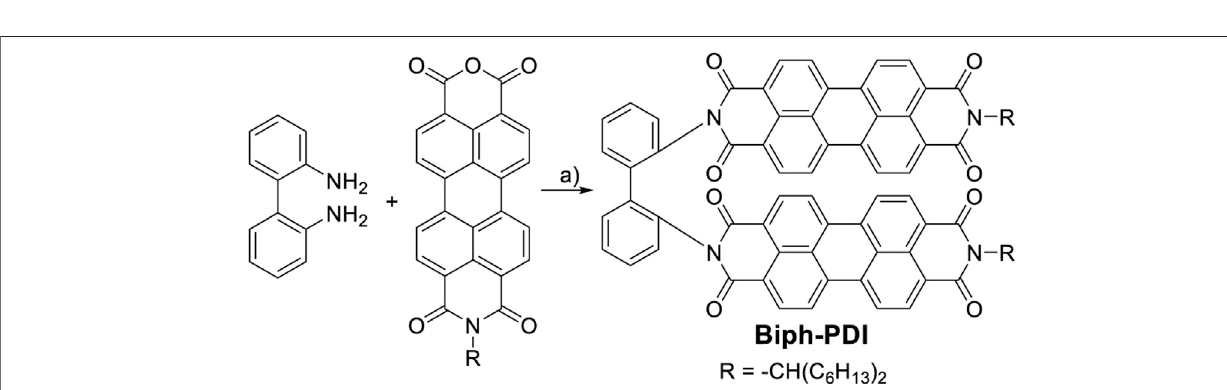
SCHEME1| SyntheticroutetoBiph-PDI.Reagentsandcondition:A)2,2 ′ -biphenlydiamine(1Eq.),N-(1-hexylhepthyl)-3,4:9,10-perylenetetracarboxylicanhydride imide (2 Eq.), imidazole as solvent, 170 ° C, 6 h